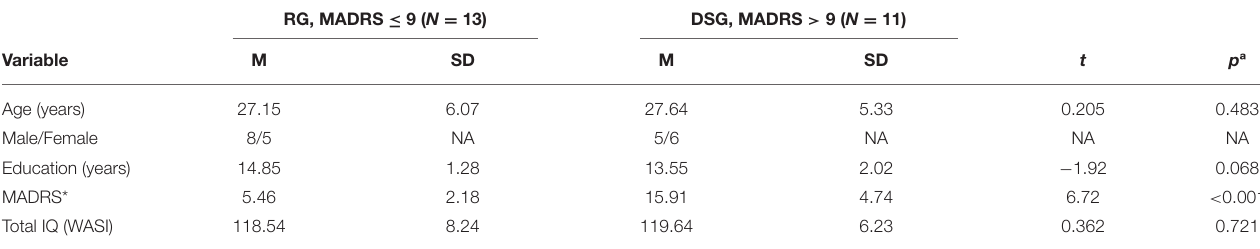
TABLE 2 | Clinical and demographic variables for the Remitted Group (RG) (MADRS ≤ 9) and the Depressed Symptom Group (DSG) (MADRS >